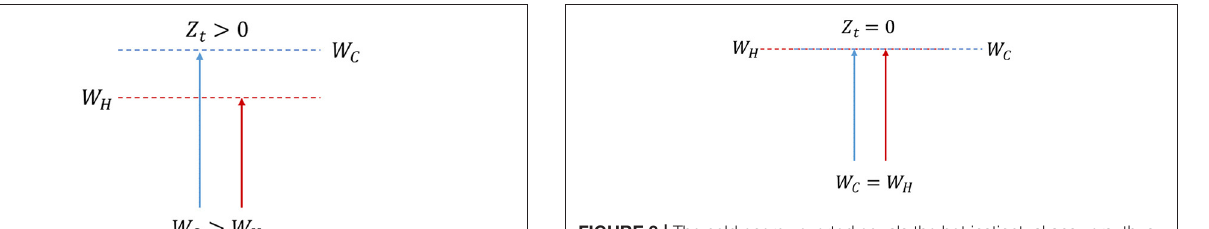
FIGURE 3 | The cold energy exerted equals the hot instinctual answers, thus deriving utility for a 0 amount; the condition for the planner to derive utility does not subsist. TABLE 2 | Combinations of possibilities in terms of decision-making under the cold and hot